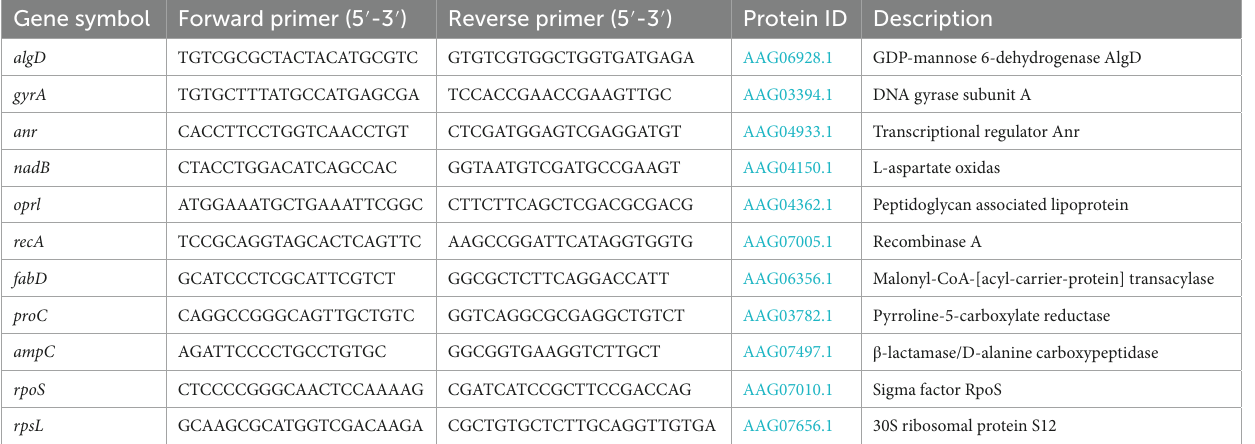
TABLE 1 Primers used and characteristics of candidate housekeeping genes in this study. Gene